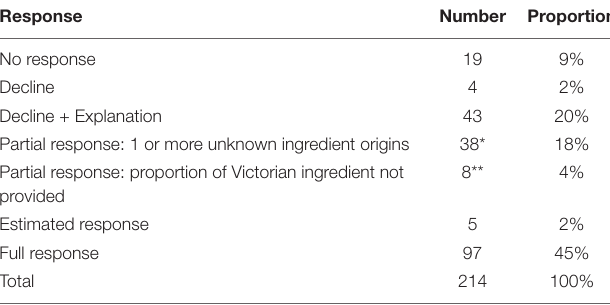
TABLE 2 | Access to data from manufacturers on the Victorian content for each food item.